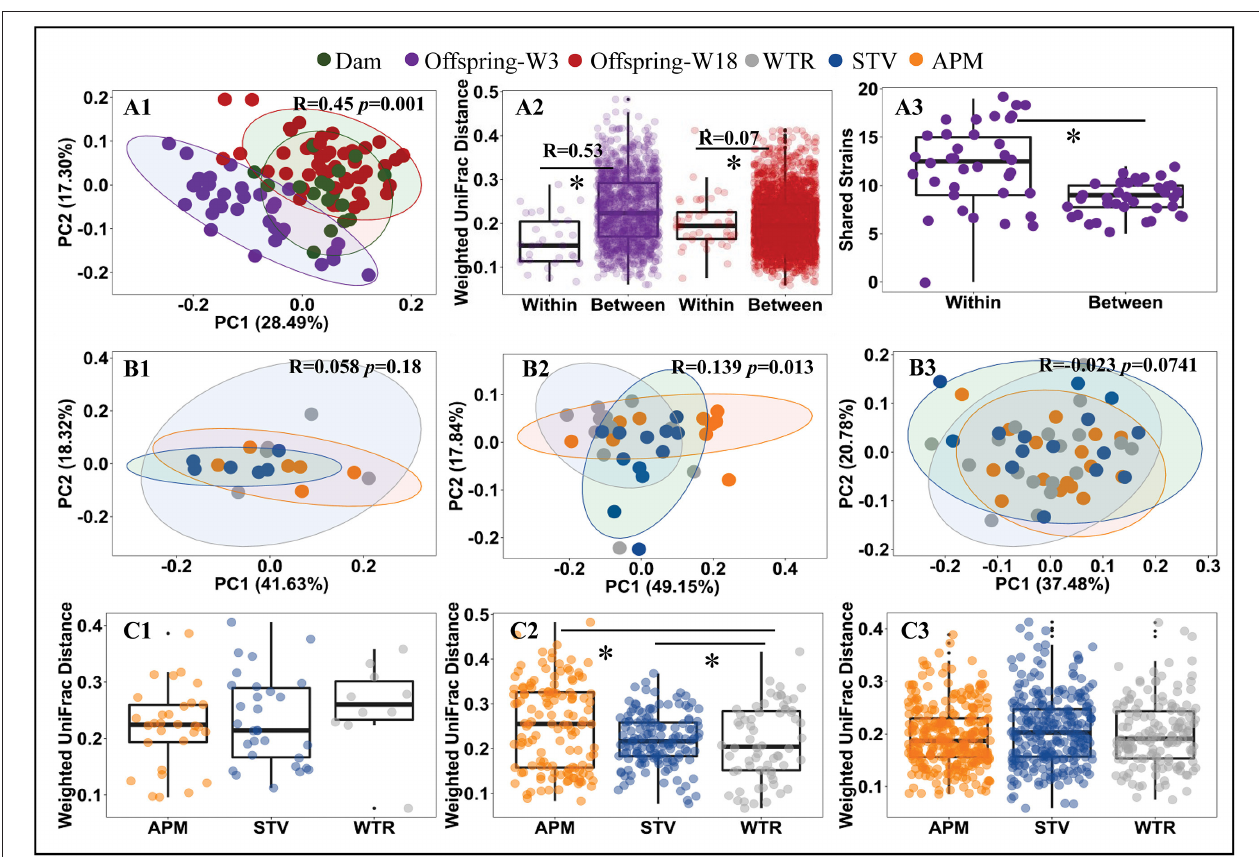
FIGURE 2 | Influence of maternal consumption of aspartame and stevia on cecal microbiota in rat dams and their offspring. Principle coordinate analysis (PCoA) (A1, B1–B3) of rat cecal microbiota; litter effects in offspring (A2) ; shared metagenomic assembled genomes (A3) between 3-week-old offspring from the same litter (left) and from different litters (right); Dietary effects in dams (C1) , 3-week-old offspring (C2) , and 18-week-old offspring (C3) . Each dot represents an individual cecal sample. Data with asterisk (*) represents a significant difference ( p < 0.05). W3, week 3; W18, week 18; APM, aspartame; STV, stevia; WTR, water